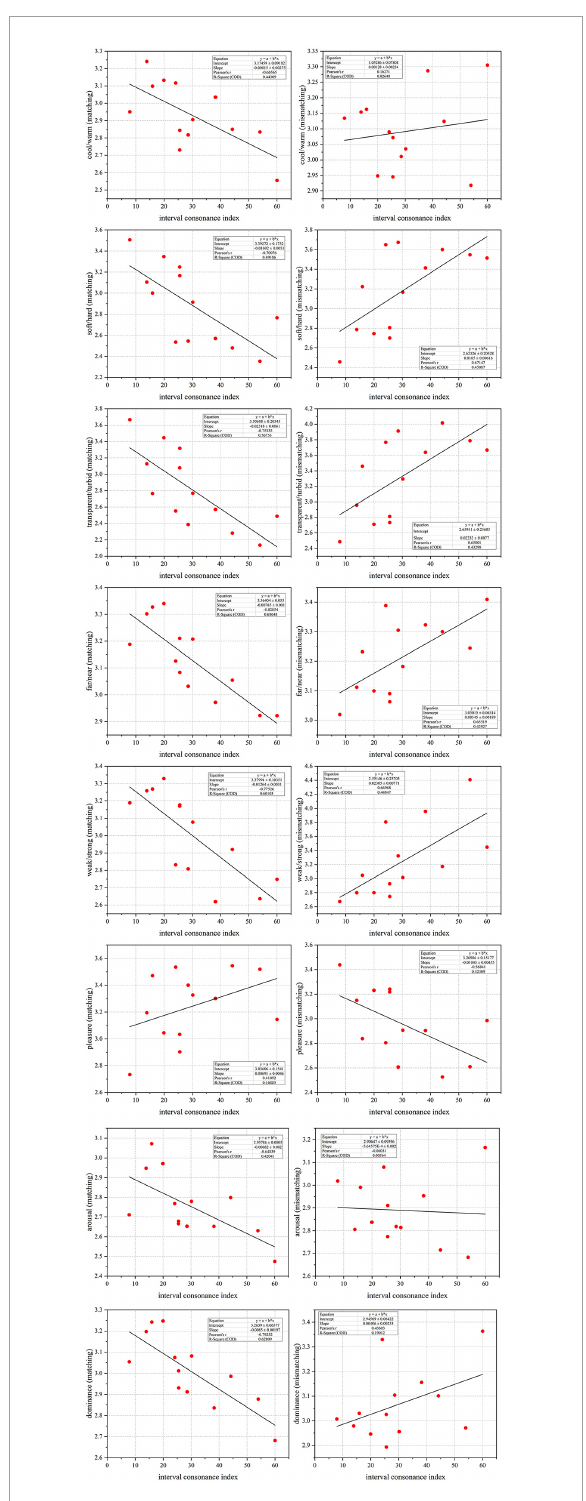
FIGURE5 The scatterplots between audio-visual perceptual attributes. Among them, the X -axis represents the interval consonance index ( I ) and the Y -axis represents a certain perceptual attribute of matched (or mismatched) multi-color material corresponding to the interval